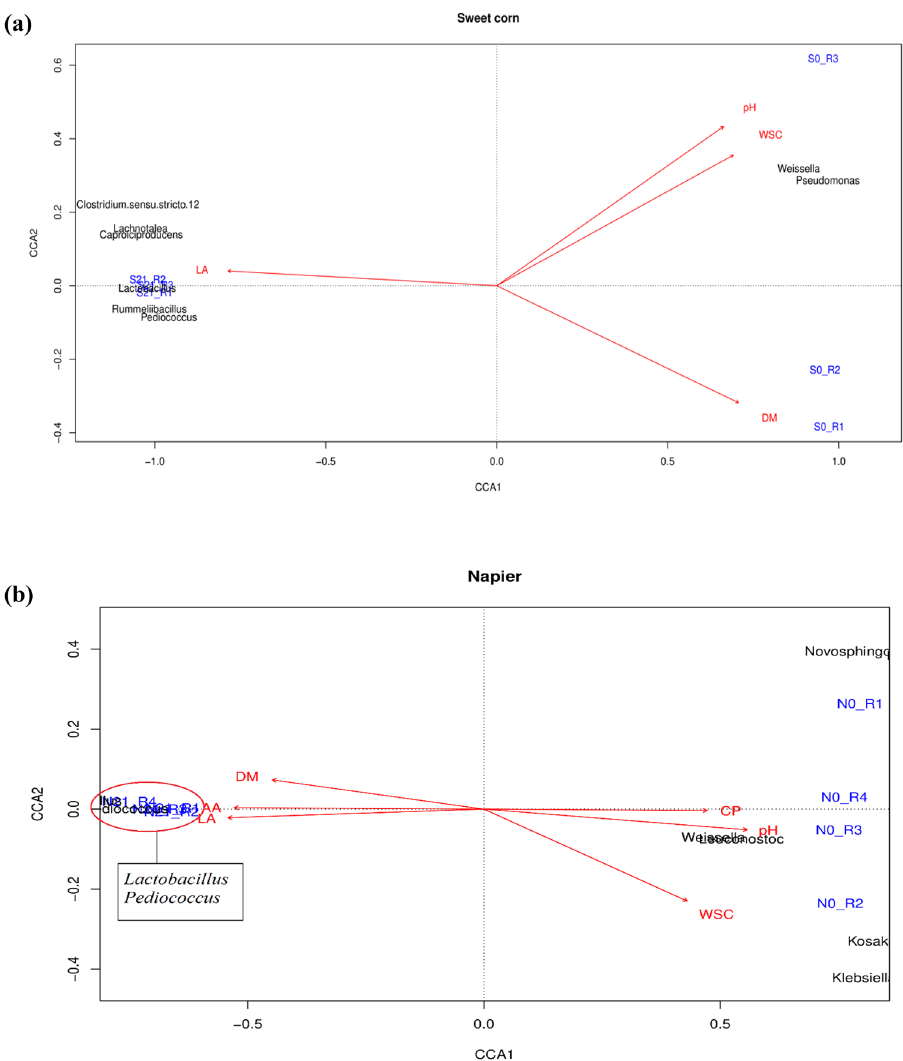
Figure 8. Correlation between physicochemical properties and bacterial taxa of fresh forage crops and silage samples by CCA analysis: (a) sweet corn (total variance explained: 98.1%, p < 0.05) and (b) Napier (total variance explained: 99.8%, p <